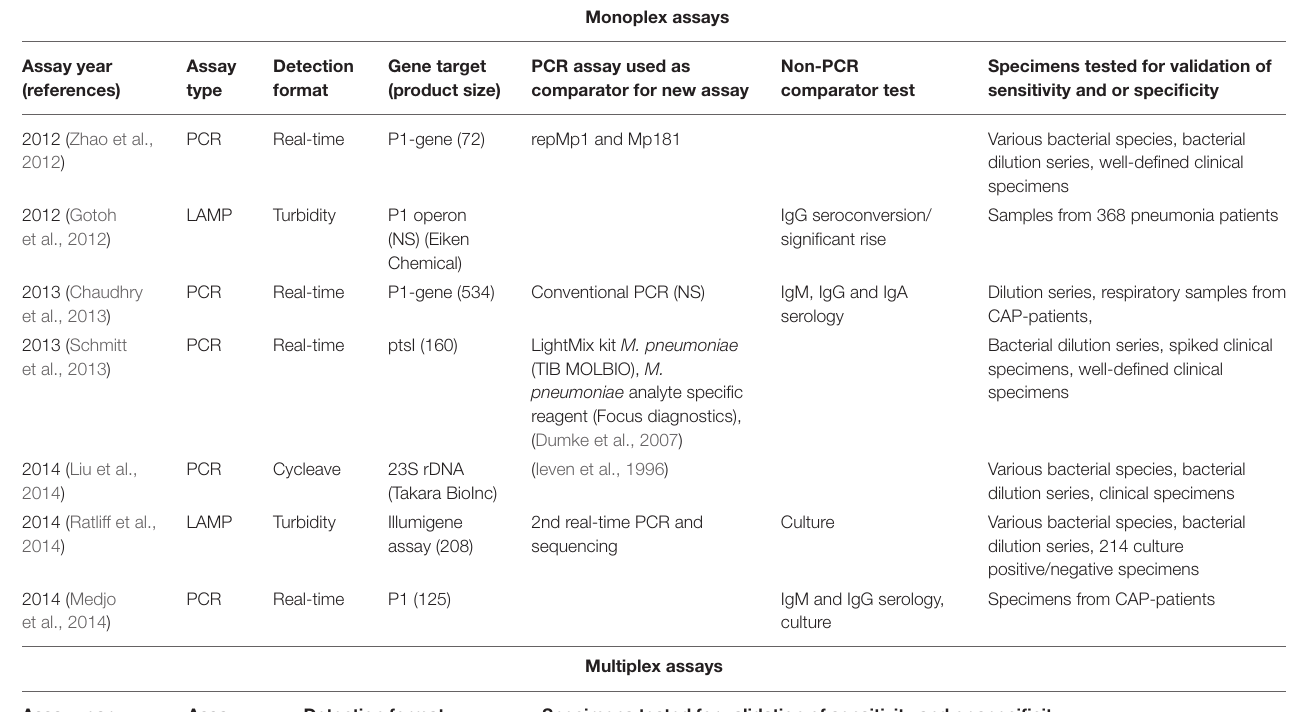
TABLE 2 | Summary of recent single and multiplex NAATs for detection of Mycoplasma pneumoniae published since the previous review, and previously validated assays used as